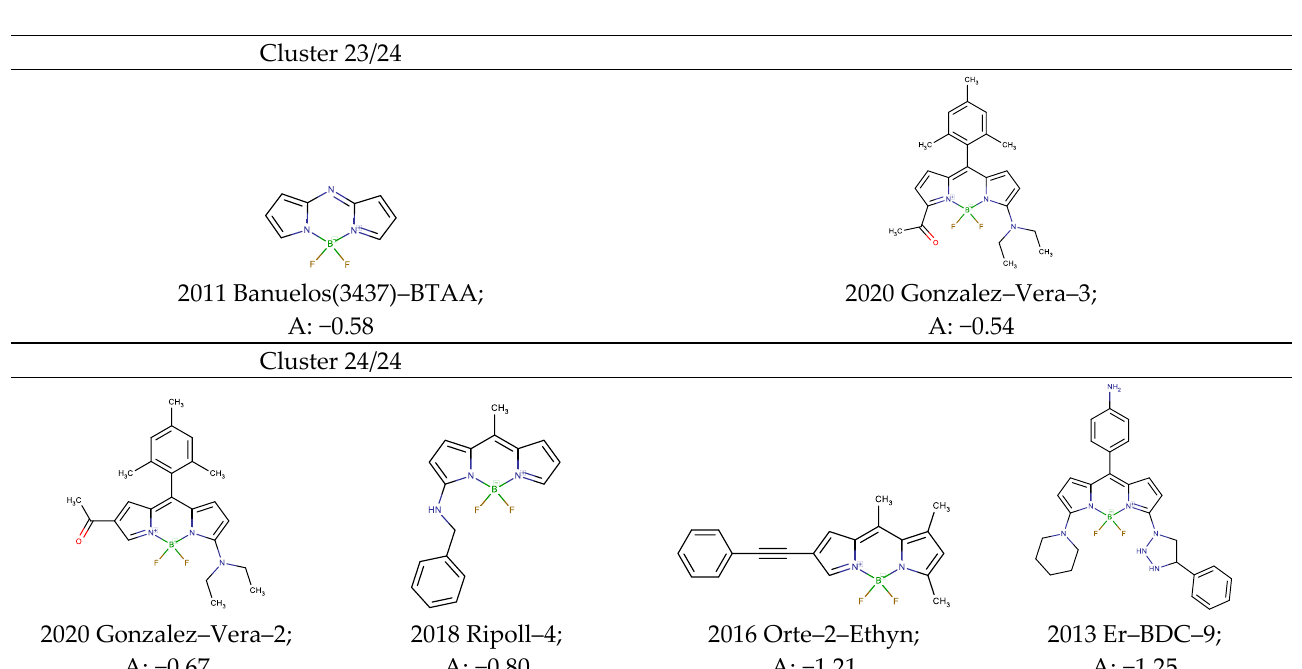
Scheme 7. Chemical structures of dyes in clusters 1/24 and 2/24, bearing a high positive solvato- Scheme 7. chromism.